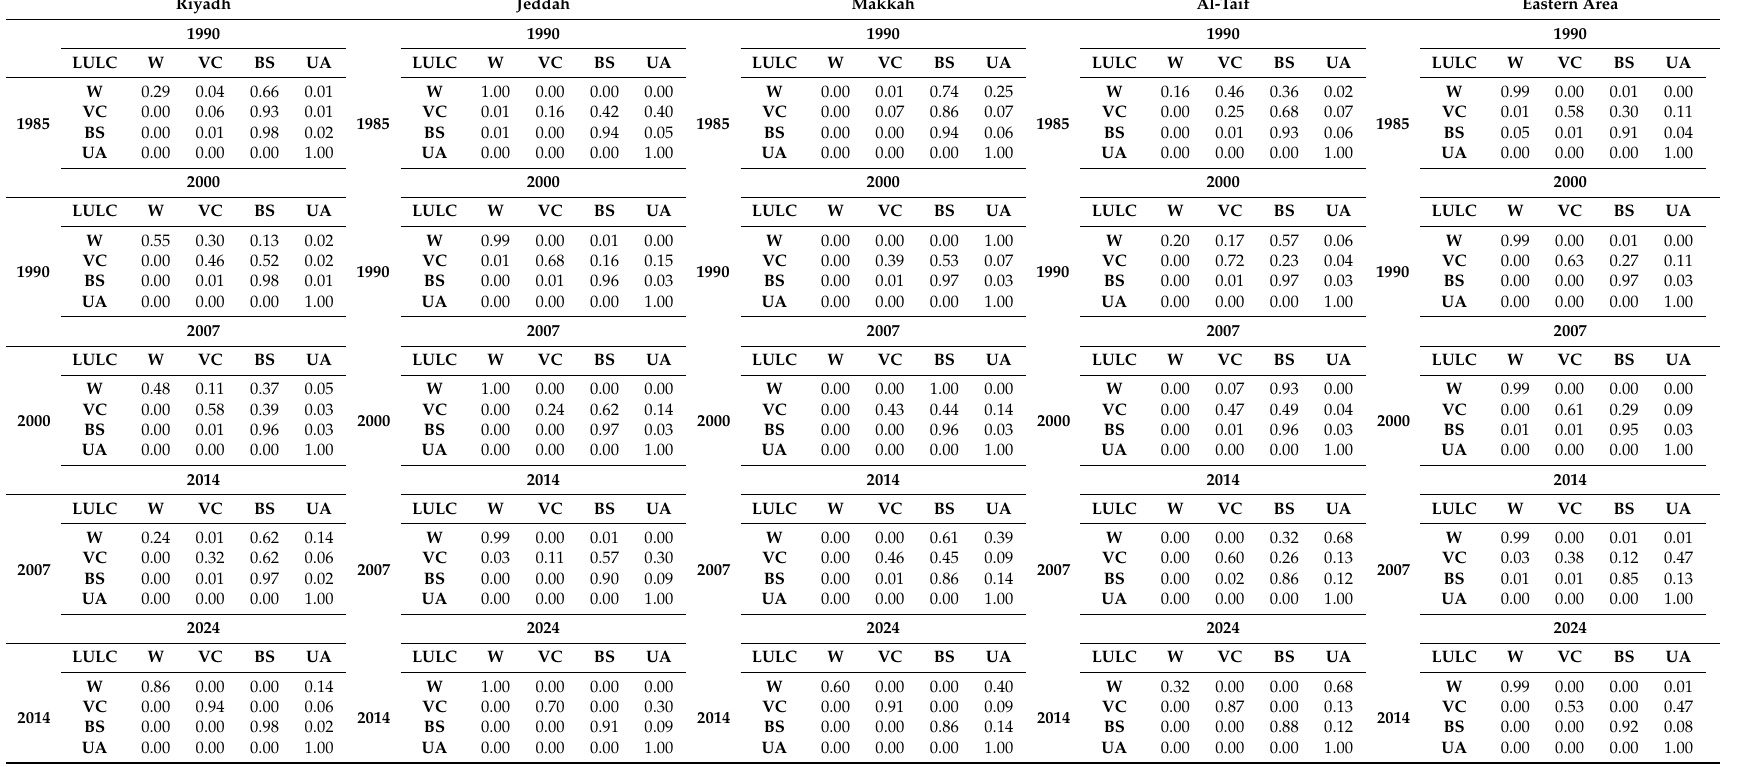
Table 5. Markov transition probability